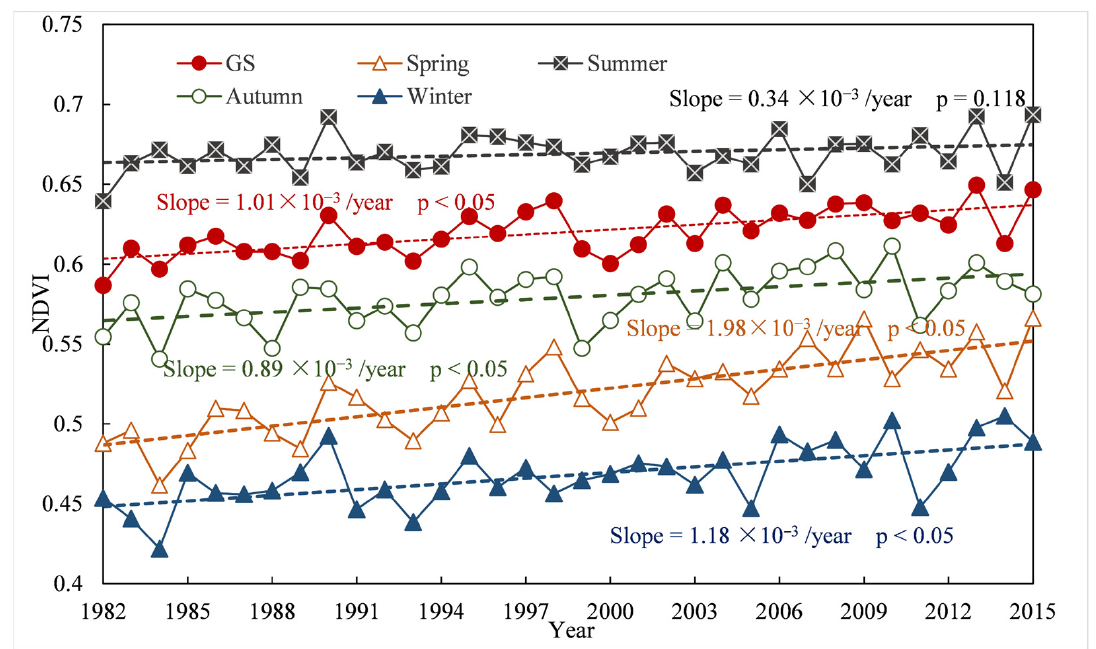
Figure 2. Interannual variations in the GS and seasonal NDVI in the YZRB from 1982 to 2015. The spatial distributions of the GS-NDVI variations in the YZRB are shown in Figure 3. Overall, the GS-NDVI values in the YZRB were relatively low in the west and high in the center (Figure 3a) with a mean GS-NDVI of 0.62, and more than 85% of the areas had mean NDVI values greater than 0.5. Areas with mean NDVI values greater than 0.7 accounted for 31% and were mainly distributed in the hilly areas covered with forests, shrublands, and grasslands around the Sichuan Basin. However, areas with mean NDVI values less than 0.5 were mainly located in the upper Jinsha River Basin and the Taiho Lake Basin. The GS-NDVI trends in the YZRB mainly increased linearly (Figure 3b), accounting for 81% of the YZRB. In particular, 21.3% of the areas with increasing rates greater than 2 × 10 − 3 /yr were mainly distributed in the central part of the YZRB. However, areas with linearly decreasing trends accounted for only 19% and were located in the western and eastern parts of the YZRB. In particular, vegetation in western Sichuan, the Taiho Lake Basin, and the Yangtze River Delta was severely degraded. The spatial distribution of the types of GS-NDVI change in the YZRB was similar to that of linear trends (Figure 3c), with significantly improved vegetation mainly in the central region and degraded vegetation in the western and eastern parts. The main types of vegetation changes in the YZRB were stable and significantly improved, occupying 24% and 53.1%, respectively. However, areas with significantly degraded vegetation accounted for only a small proportion